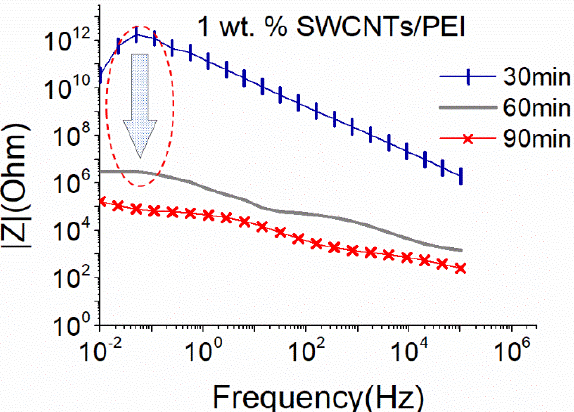
Figure 7. EIS plots of aqueous dispersion with 1 wt.% SWCNTs, using the big sonication probe at an amplitude of 25%, in the presence of PEI (18.6 W).